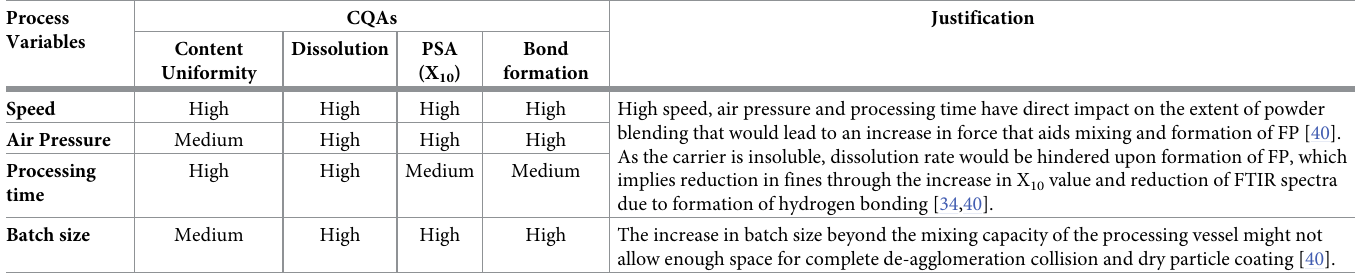
Table 5. Risk assessment of the input and process parameters against the CQAs with relevant justification to produce FP with extended release profile. Process Variables